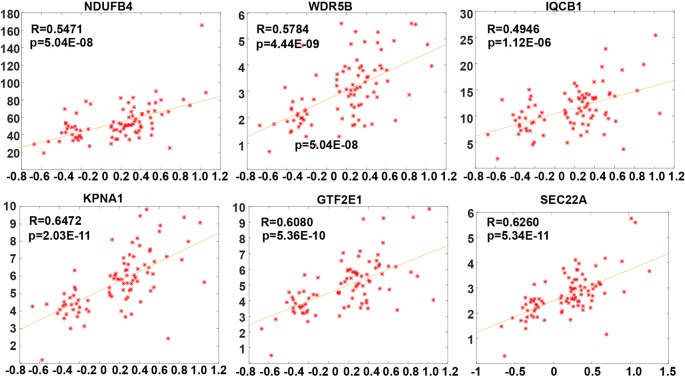
The dosage sensitivity of six prognostic dosage-sensitive genes (PDSGs). The X-axis represents the somatic copy number alteration (SCNA) value and Y-axis represents the FPKM of genes.